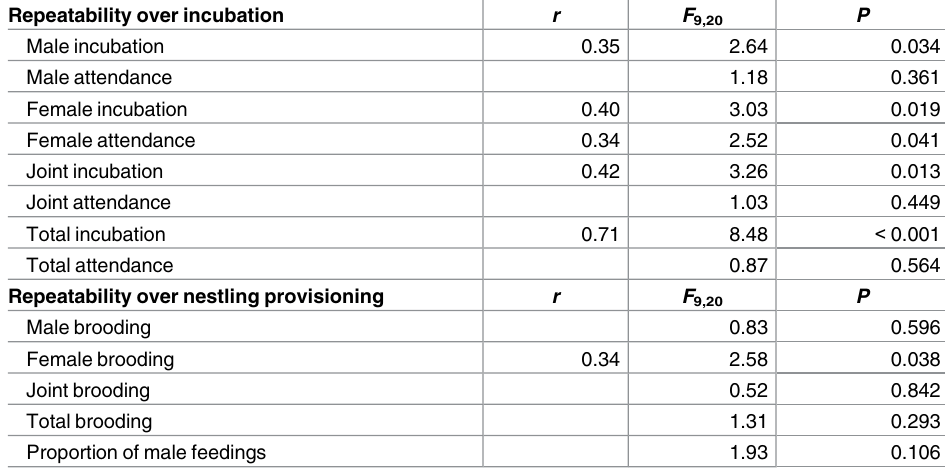
Table 5. Consistency of parental effort within reproductive stages in zebra finch